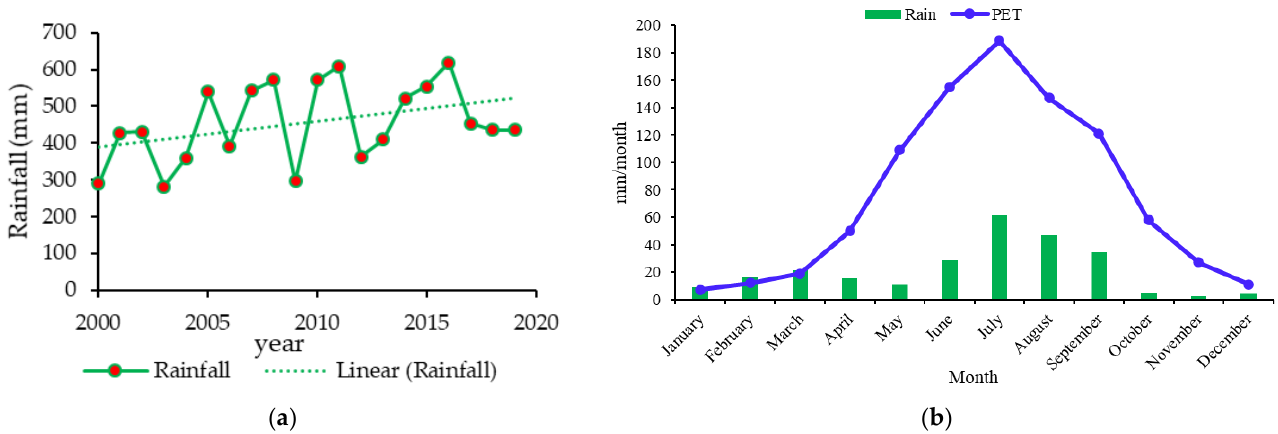
Figure 5. ( a ) Long-term average annual rainfall (2000 – 2019) and ( b ) long-term average monthly rainfall and potential evapotranspiration (2000 – 2019).